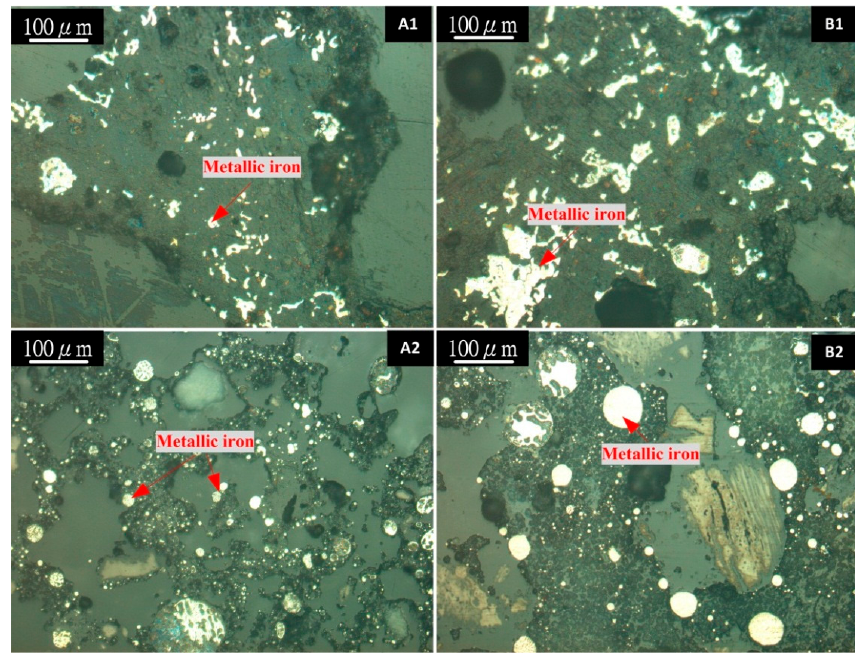
Figure 12. Microstructures of reduced briquettes. ( A1 , A2 ) External and internal of reduced briquettes without sodium sulphate. ( B1 , B2 ) External and internal of reduced briquettes with 15% sodium sulfate.